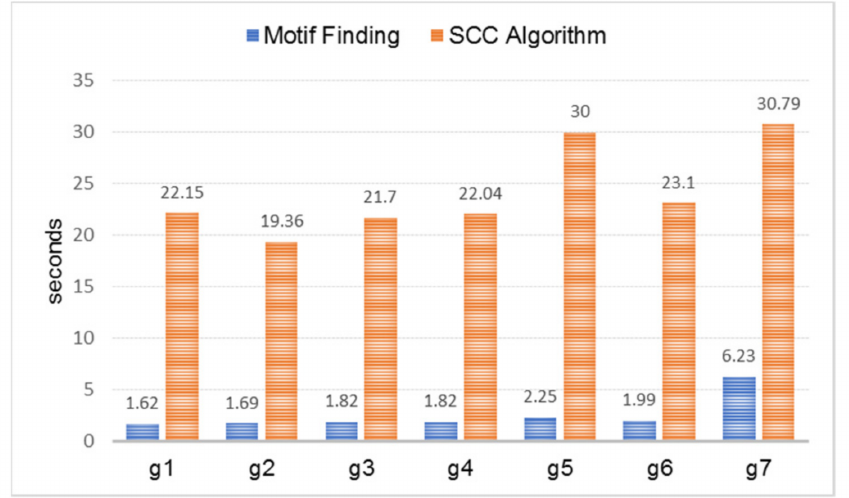
Figure 5. Execution time of motif finding vs. SCC